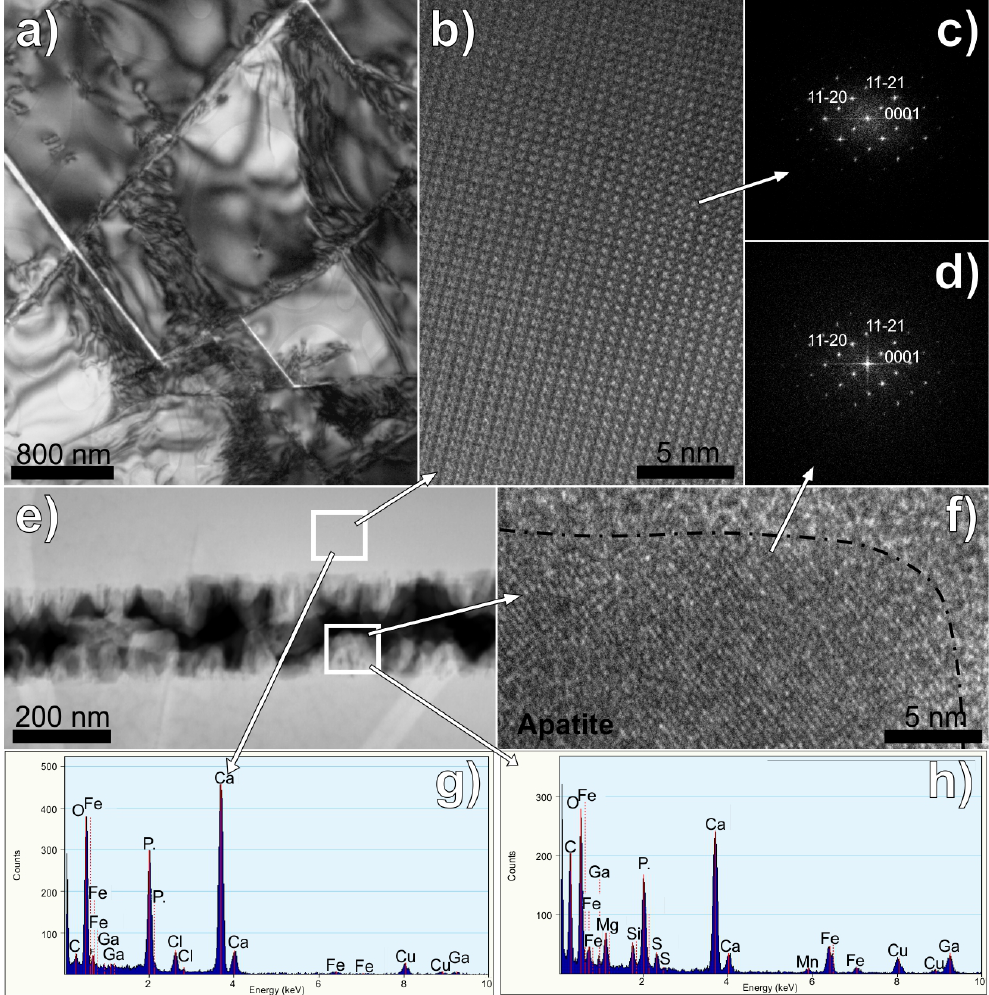
Figure 6. TEM photomicrographs of apatite in NWA 10153: ( a ) bright-field image of the cell wall formation at an early stage of recovery and annealing; ( b ) lattice fringe image of first-generation F-rich chlorapatite; ( c ) diffraction pattern (FFT) corresponding to b; ( d ) indexed diffraction pattern (FFT) from the area in f. Note that the indices are identical to those in c. Thus, the crystallographic orientation was identical between the first- and second-generation apatites; ( e ) high-angle annular dark-field (HAADF) image of the first-generation F-rich chlorapatite ( b ) and a vein of the second-generation fluorapatite in a crack ( f ); ( f ) lattice fringe image of a second-generation fluorapatite; ( g ) EDX analysis of a first-generation, F-rich chlorapatite. Note the presence of a Cl peak; ( h ) EDX analysis of a second-generation fluorapatite. Note the lack of a Cl peak and the presence of the Fe, Si, and S peaks.